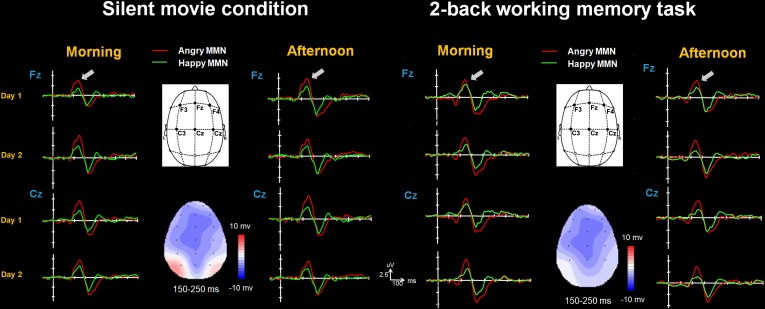
The happy MMN (green lines) and angry MMN (red lines) recorded from F3 to C4 electrodes, averaged across all subjects when watching the silent movie and performing the 2-back working memory task. The gray arrows indicate the time window of MMN.